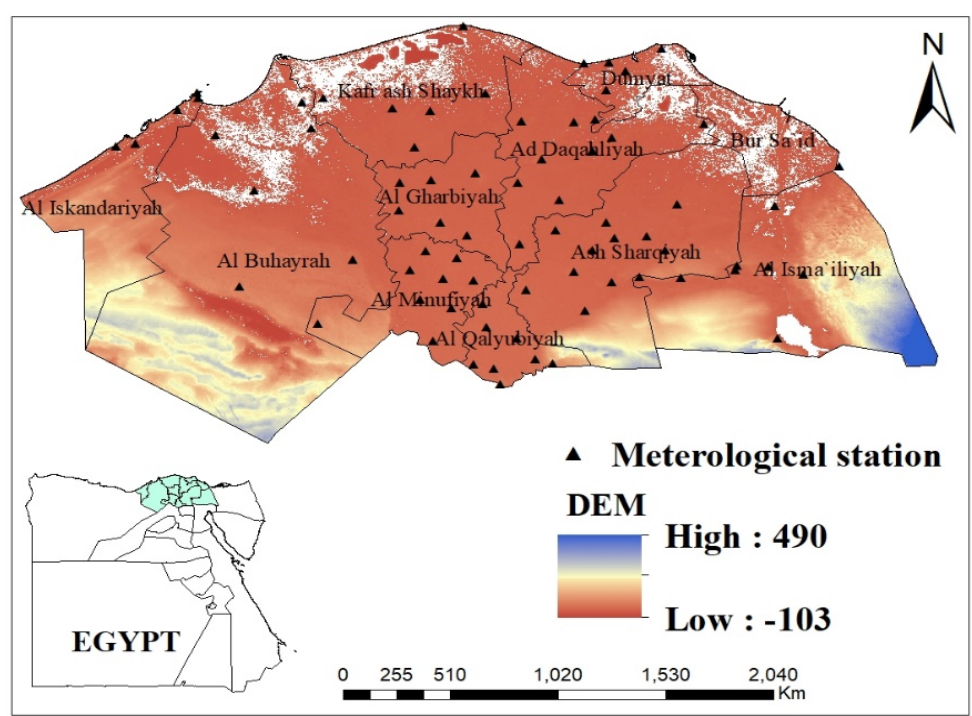
Figure 1. Location of the study area and the meteorological stations.